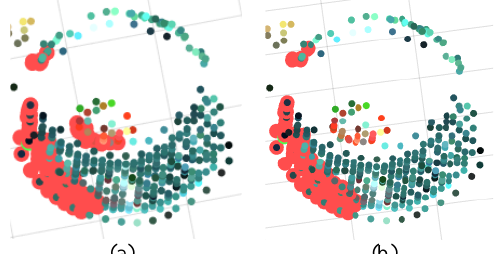
Figure 5. Neighborhood of (a) eigenentropy-based method, and (b) spectrally improved method. The red points are the neighborhood points.